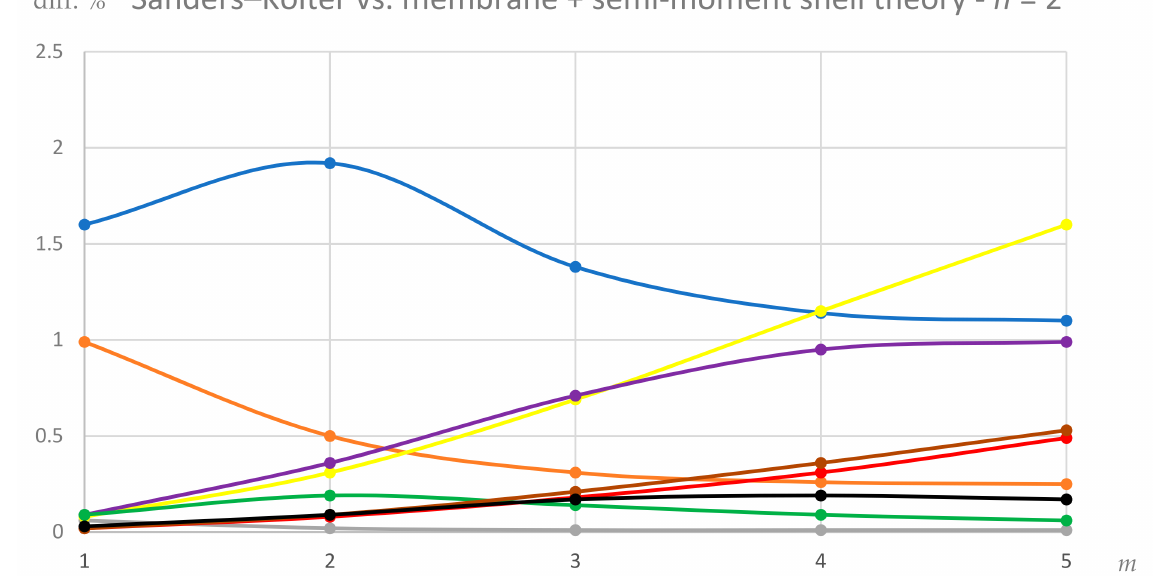
Figure 12. Simply supported DWCNT of Table 1 with different values of aspect ratio L / R 2 and thickness ratio R 2 / h . Shell-like modes ( n = 2). Comparisons between extended Sanders–Koiter and membrane + semi-moment shell theory, where L / R 2 = 10, R 2 / h =